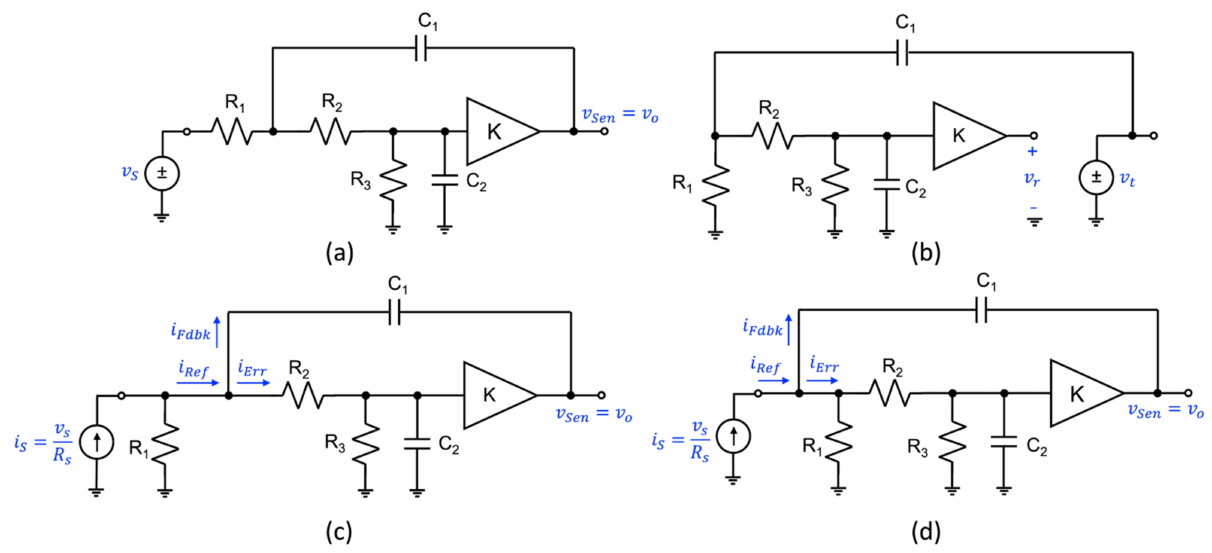
Figure 12. Comparing noncompliant, compliant feedback topologies with the Middlebrook loop injection method for extracting its return ratio: ( a ) voltage-input voltage-output active filter circuit, ( b ) evaluating the return ratio of the active filter circuit using Middlebrook’s injection method by replacing the dependent voltage source related to the VCVS with an independent voltage source, ( c ) Norton equivalent circuit representation that is noncompliant with Black’s feedback topology, and ( d ) Norton equivalent circuit representation that is